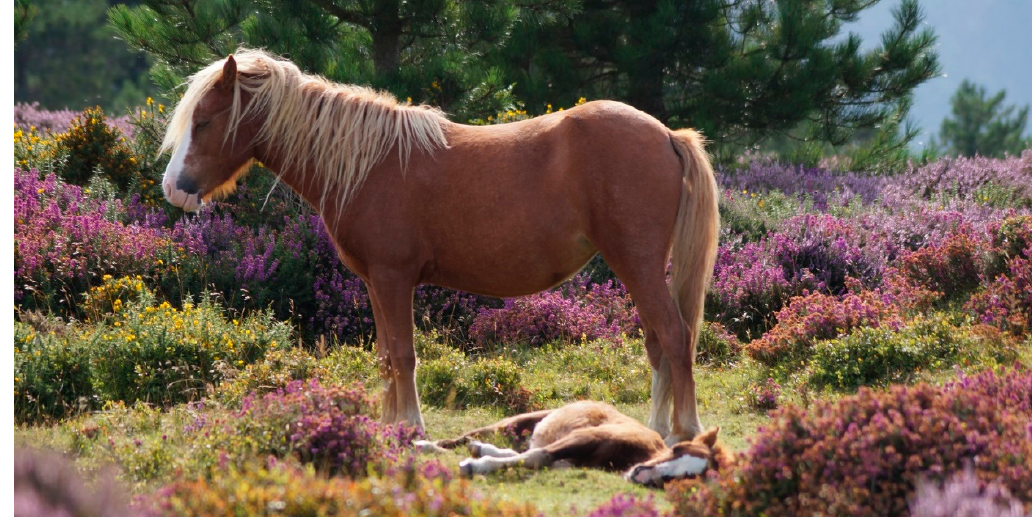
Figure 1. Carneddau pony mare with foal at foot. The image illustrates the difficulty of accessing hoof shape. Patches of grass are surrounded by heather ( Calluna vulgaris ) and gorse ( Ulex europaeus ).